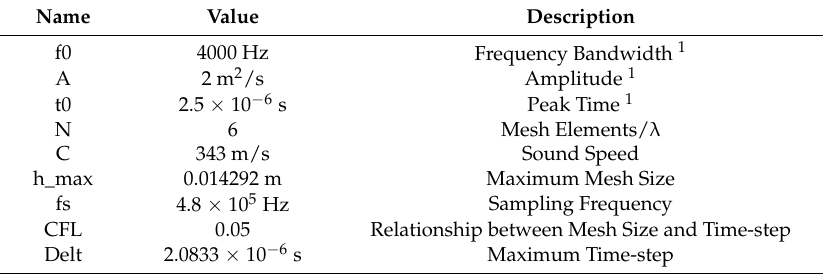
Table A1. COMSOL Multiphysics simulator parameters.